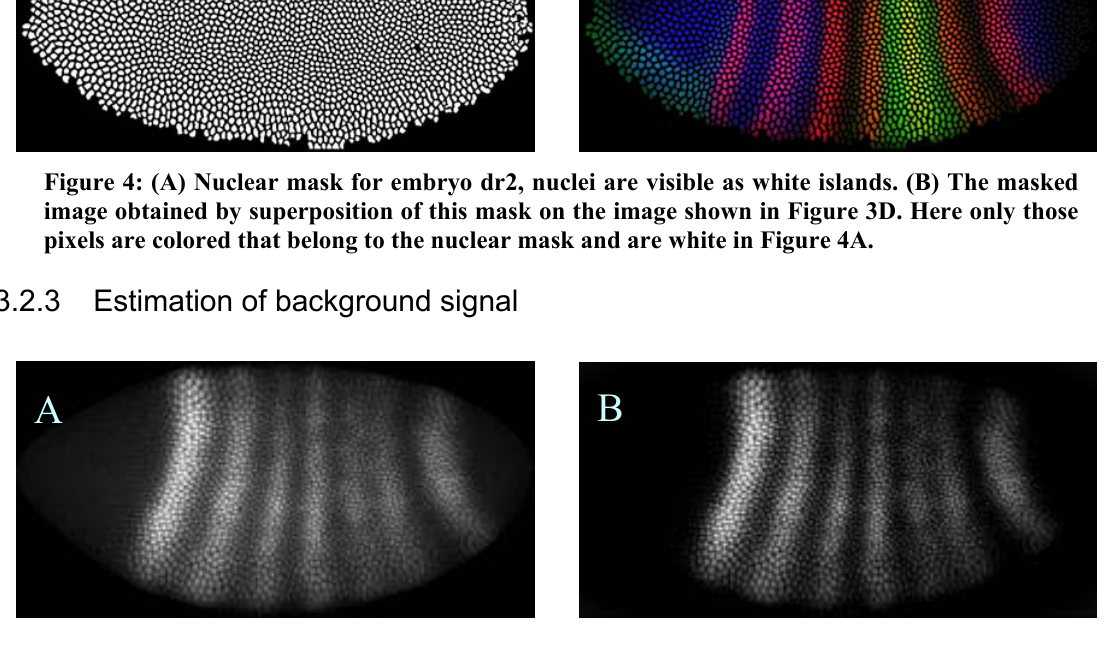
Figure 5: Expression pattern of gene even-skipped in embryo cq3 belonging to temporal class 4. (A) Original image, (B) the same image without